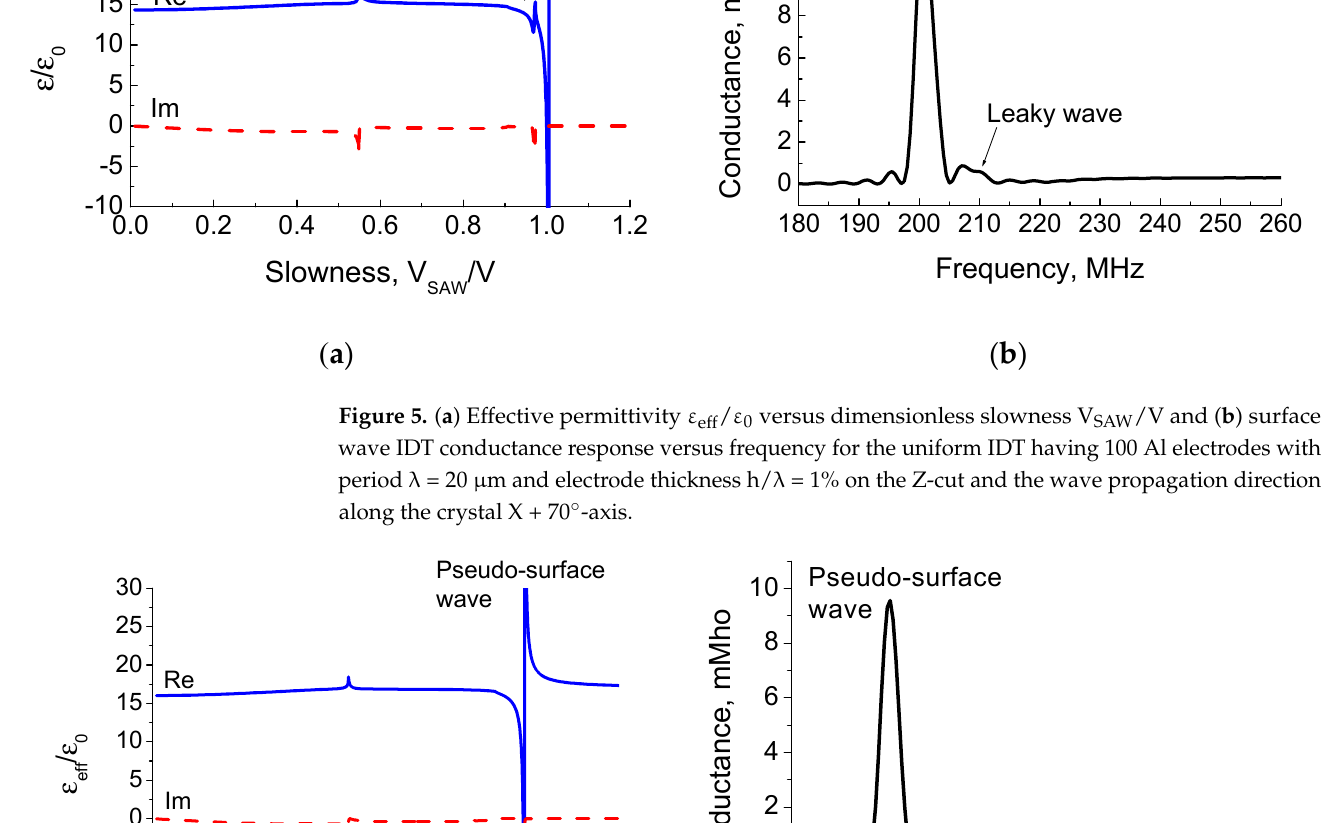
( b ) Figure 4. Relative delay time as a function of substrate temperature: ( a ) for the SAW propagation